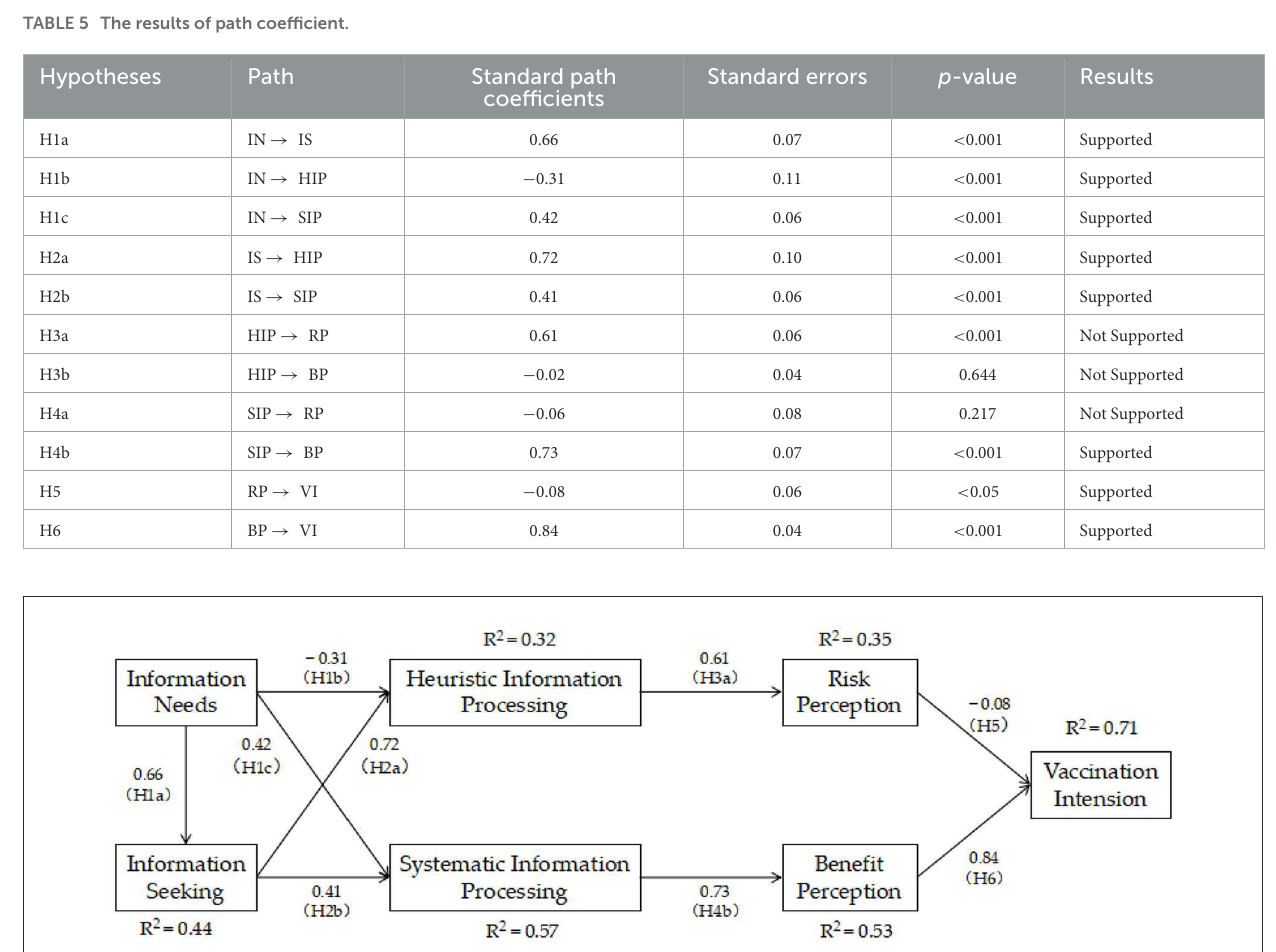
determine vaccination risks and to make vaccination